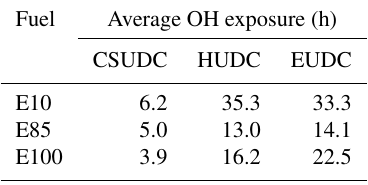
Table 1. The average OH exposures during the driving cycles.